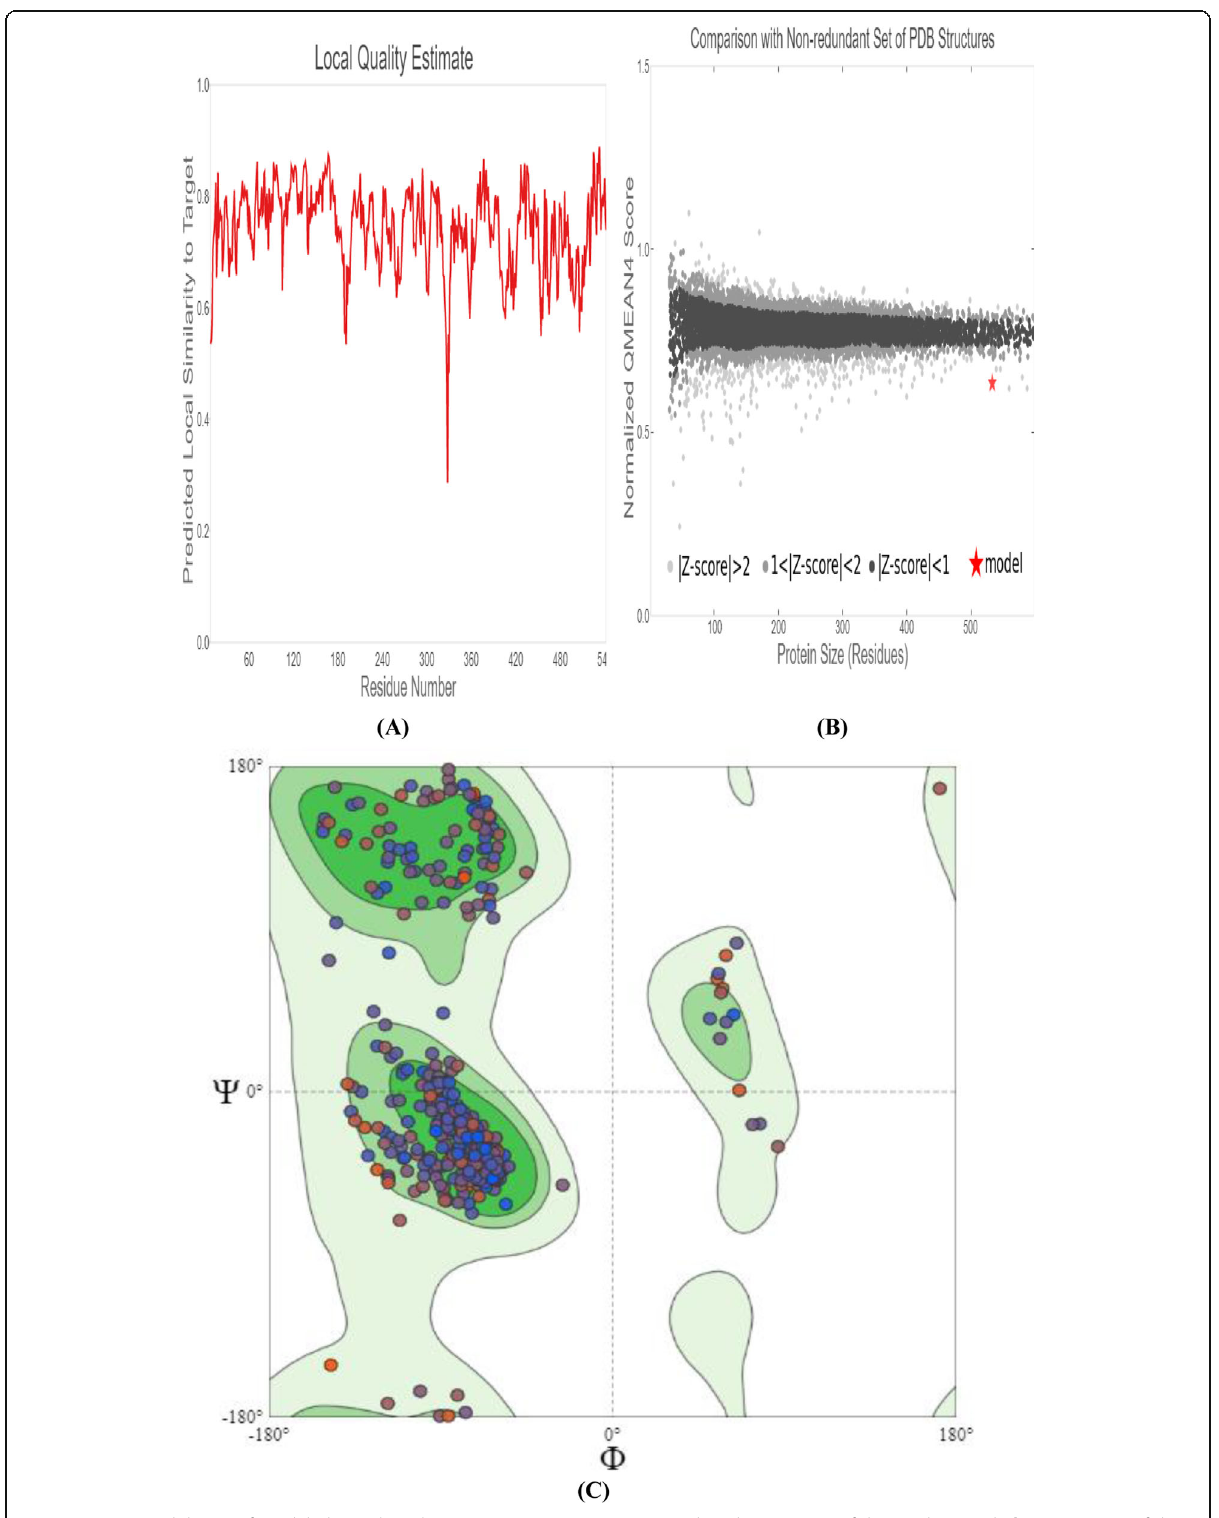
Fig. 4 Structure validation of modeled M. tuberculosis QcrB protein structure: a Local quality estimate of the residue graph. b Comparison of the modeled protein structure with non-redundant set of PDB structures. c Ramachandran plot of the homology modeled QcrB protein for all non-glycine/proline